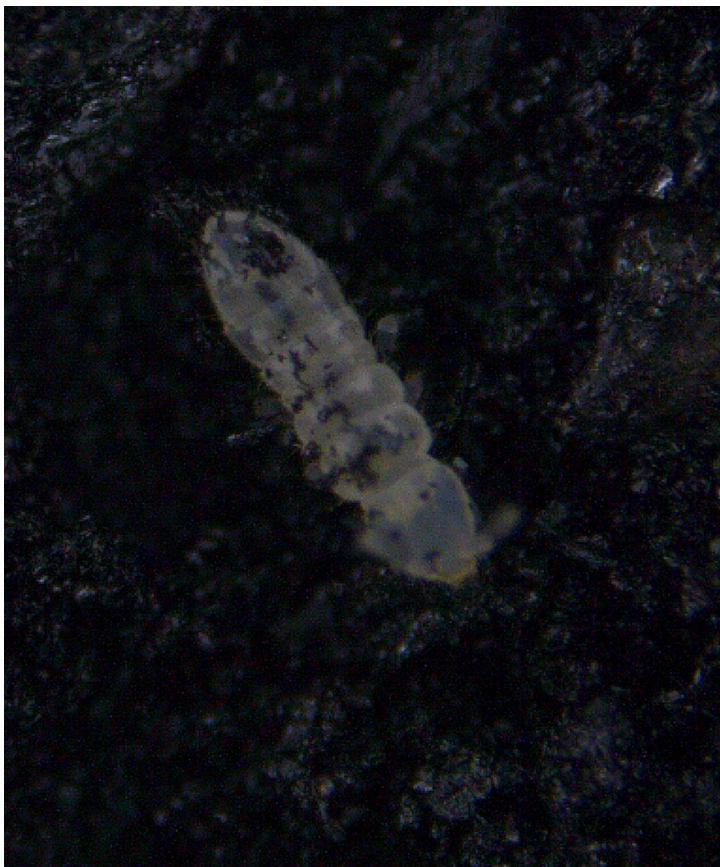
Fig 2. Folsomia candida individual covered with pine bark biochar particles and biochar particles in the gut.